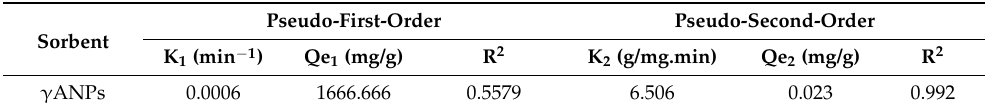
Table 2. Kinetic constants of Tl(I) removal on γ